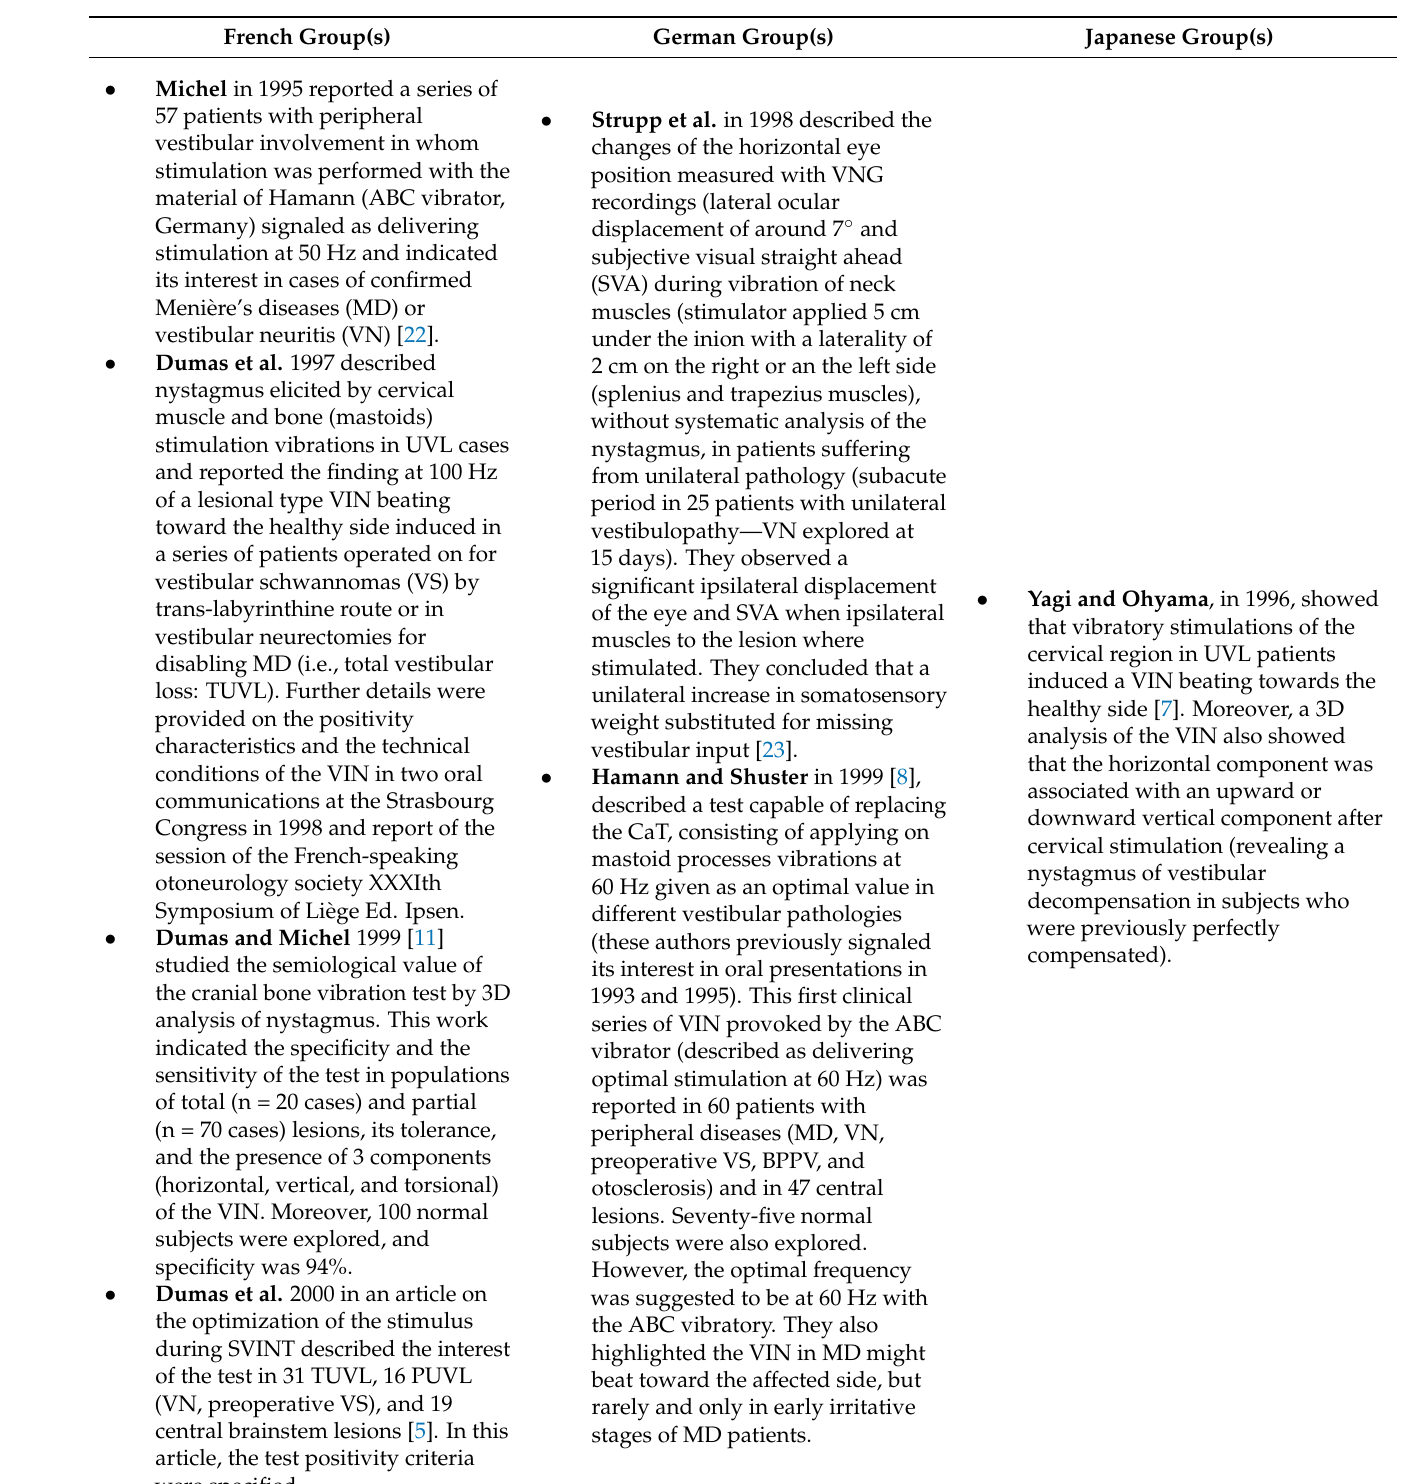
Table 1. Summary of clinical findings between the years 1990 and